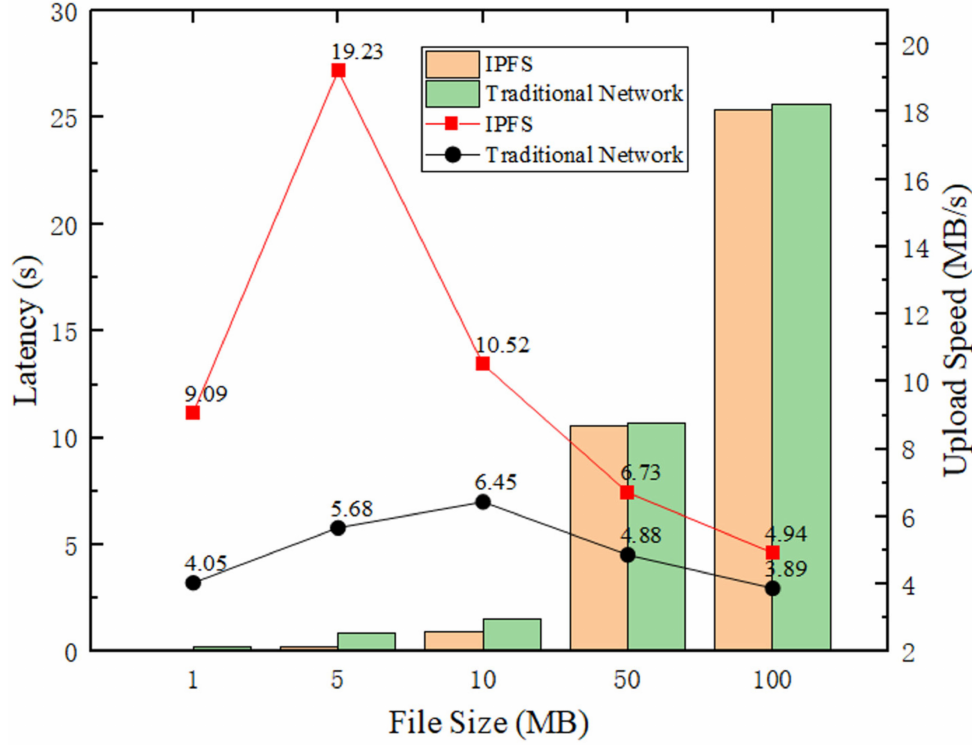
Figure 7. Performance comparison of file transfers in traditional and IPFS networks using different file